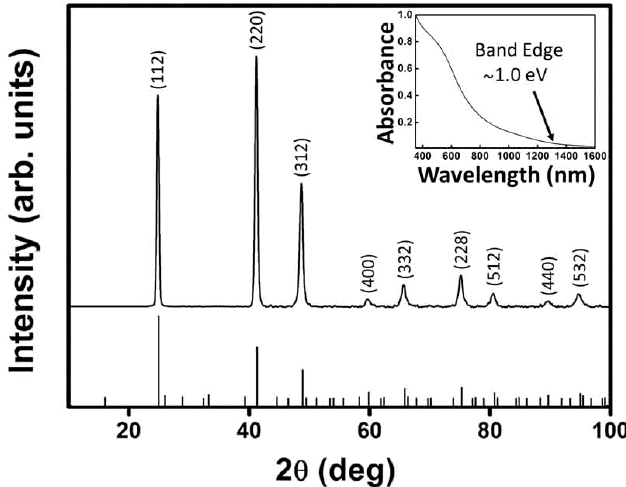
Figure 1. X-ray diffraction (XRD) of CuInTe 2 nanocrystals (2 mmol stearic acid). The peak labels correspond to those of sphalerite (cubic) CuInTe 2 (PDF No. 43-1401). Inset: CuInTe 2 nanoparticles are dispersed in toluene and their UV-vis-near infrared absorbance spectrum is demonstrated.